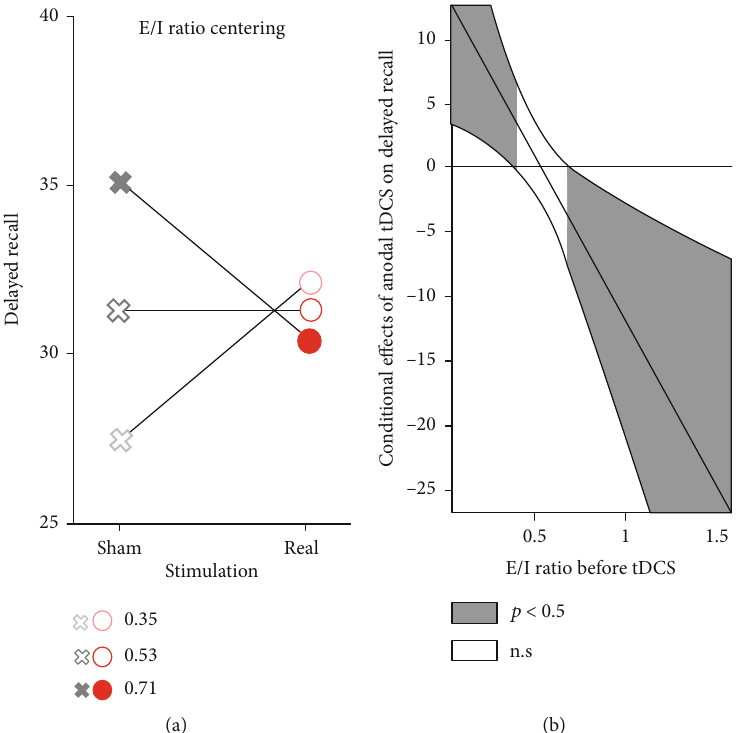
Figure 4: Di ff erential bene fi ts of anodal tDCS. (a) Moderation e ff ect of E/I ratio prior to stimulation on the relationship between stimulation and remembered words in delayed recall 1 for three centerings of E/I ratio ( − SD, mean, and +SD). Conditional e ff ects of performance in delayed recall 1. (b) Johnson-Neyman con fi dence bands indicate ranges of E/I ratios in which the latter has a signi fi cant predictive